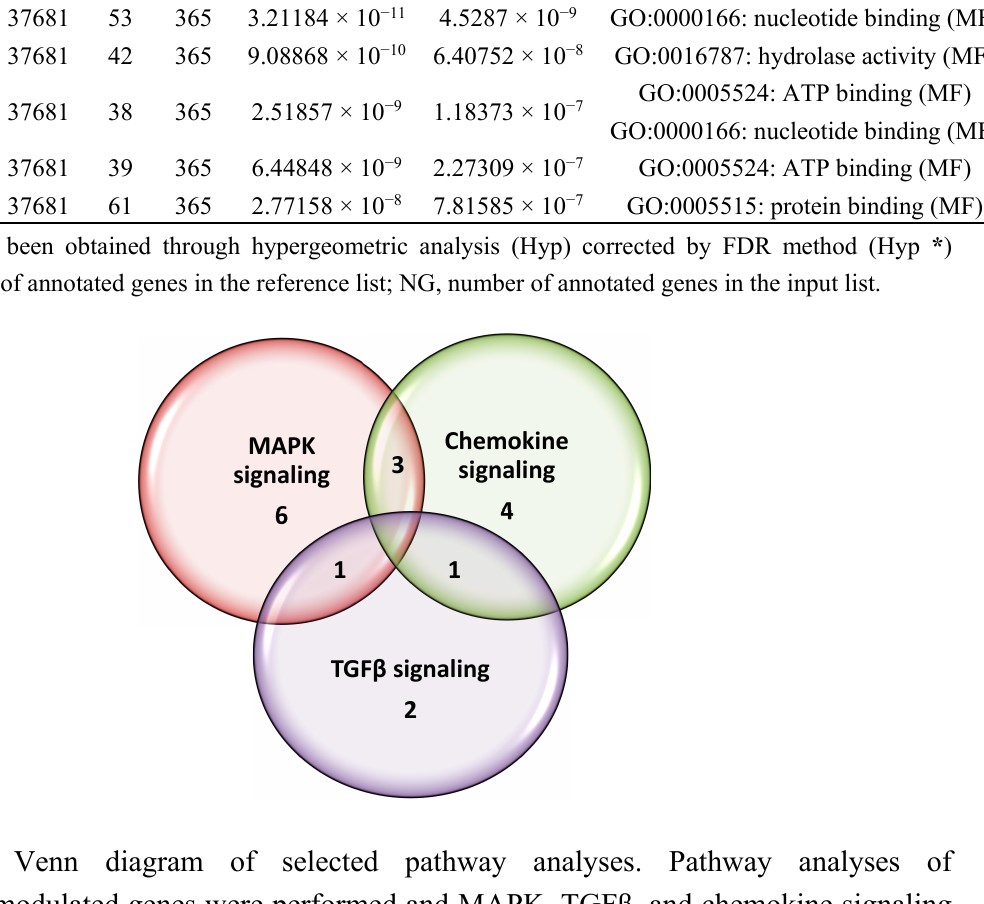
Table 2. Gene co-occurence annotations found by GeneCodis (molecular function) for genes downregulated by Soyselect ® in perigonadal white adipose tissue. Genes